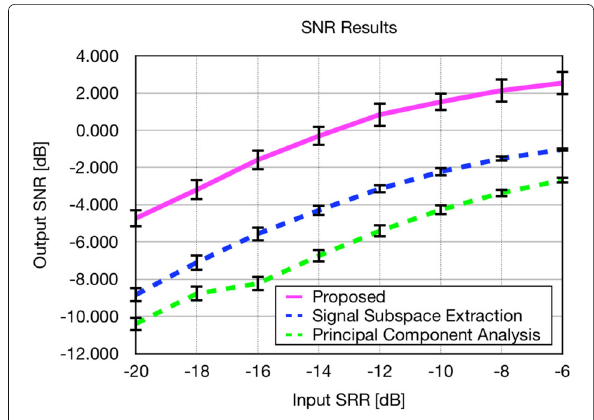
Fig. 8 SNR retrieved from the proposed, SSE, and PCI algorithms for various input SRRs. The vertical error bars indicate the standard